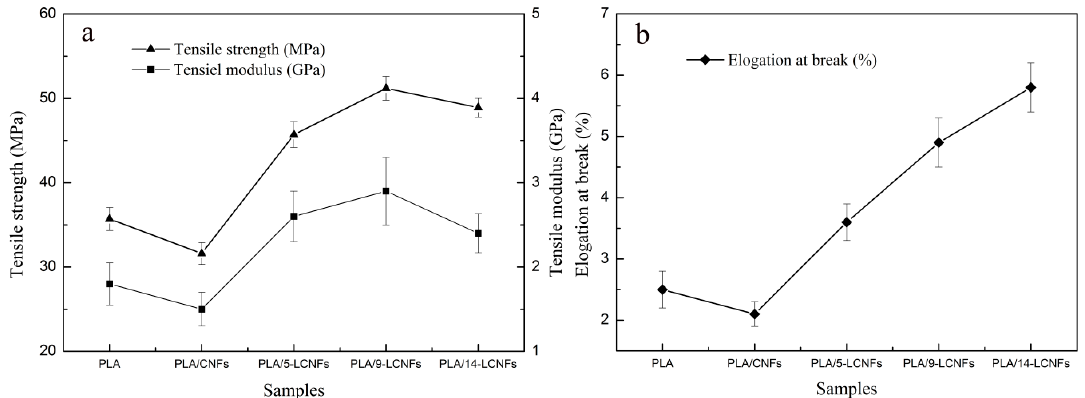
Figure 3. Mechanical properties of PLA and the PLA/LCNFs composites determined by tensile testing. ( a ) Tensile strength and modulus and ( b ) elongation at break.